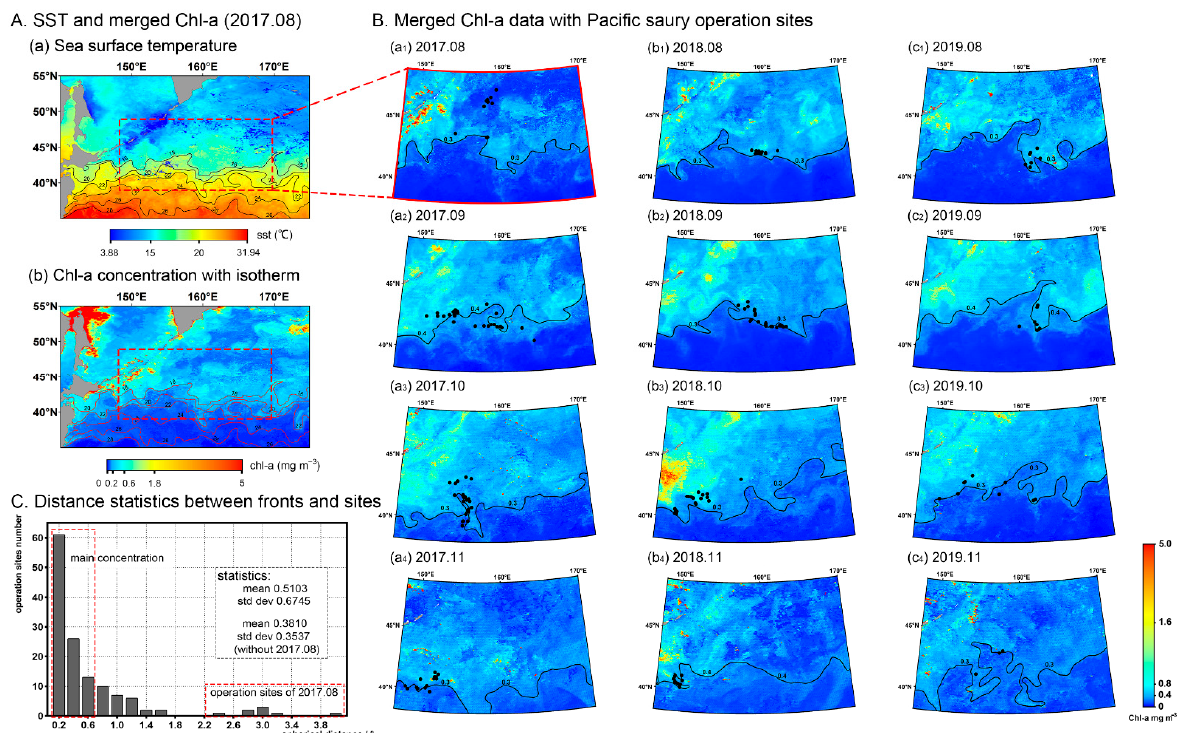
Figure 13. ( A ) Comparison of Kuroshio extension (represented by SST) and merged Chl-a variation (monthly data of August 2017). ( B ) Monthly merged products of three satellites’ data with Pacific saury operation sites. The solid lines are the isoconcentrate lines of Chl-a. ( a 1 – a 4 ) are from August 2017 to November 2017; ( b 1 – b 4 ) are from August 2018 to November 2018; ( c 1 – c 4 ) are from August 2019 to November 2019. ( C ) Histogram of spherical distance statistics between Chl-a fronts and operation sites.